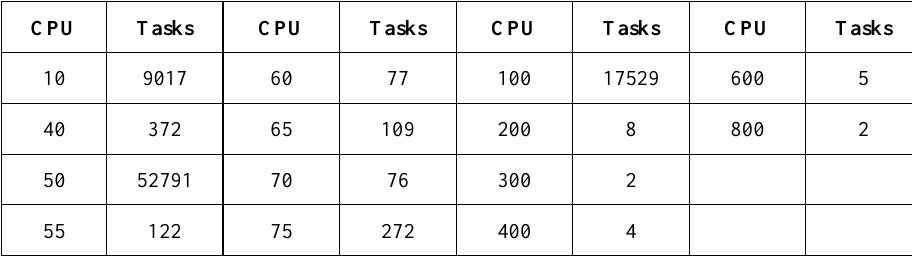
Table 1. Planned CPU vs Task